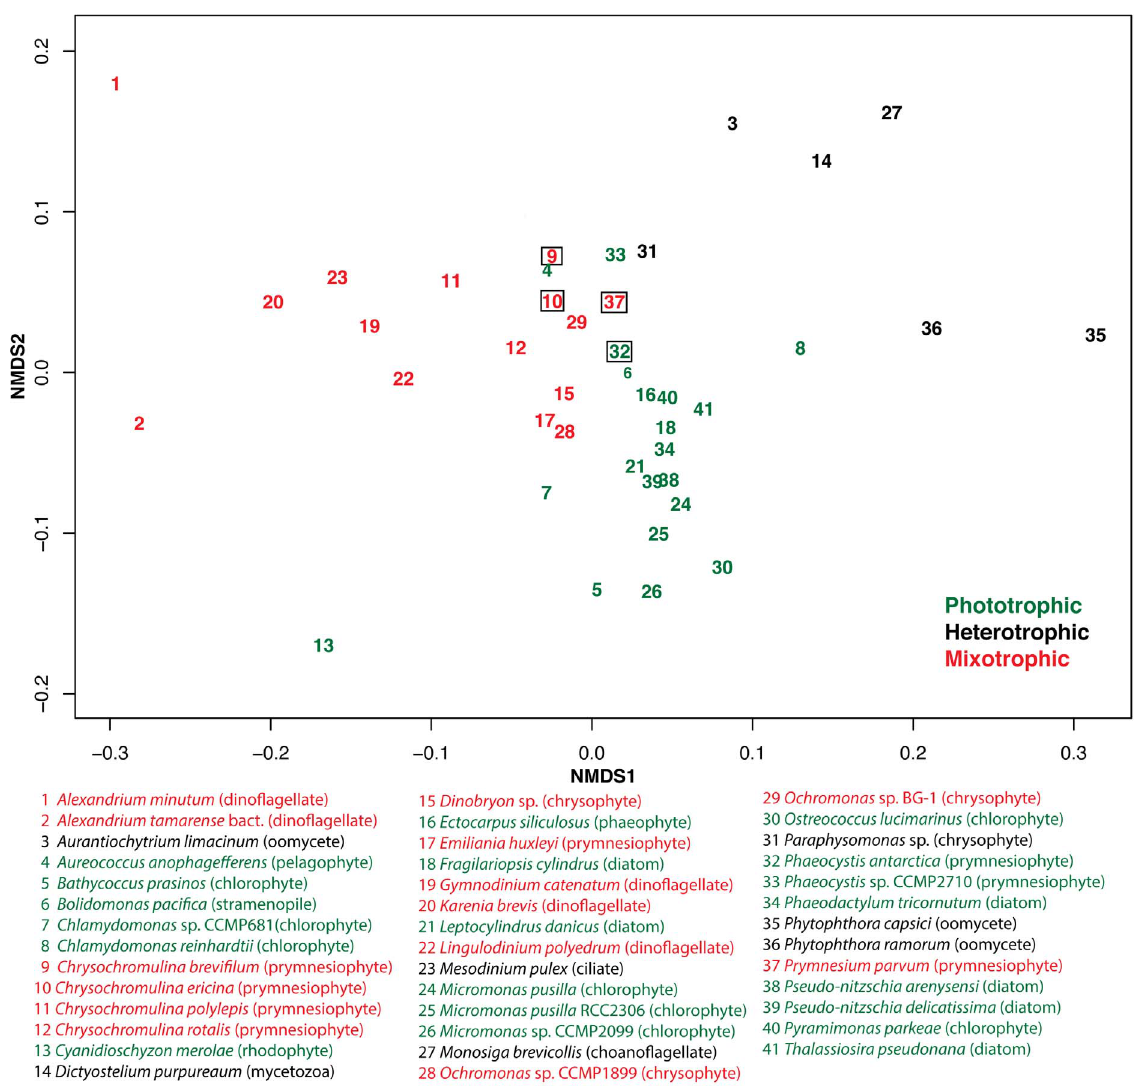
Figure 5. Nonmetric multidimensional scaling (NMDS) plot of the KOG distributions of the four prymnesiophytes in this study and of other protistan genomes and transcriptomes. The genomes were obtained from the Joint Genome Institute database, and the transcriptomes were obtained from the Marine Microbial Environmental Transcriptome Sequencing Project (MMETSP) database. The stress value for this plot was 0.12, which indicates that the two-dimensional plot is a good representation of the data. The four target species in this study are highlighted in boxes. The trophic modes of each organism are denoted in green (phototrophs), black (heterotrophs) and red (mixotrophs).